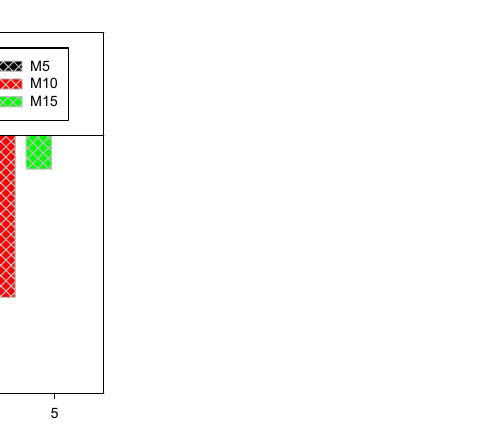
1 bmep, bar. Figure 11. Reduction percentage of BSFC with bmep for tested